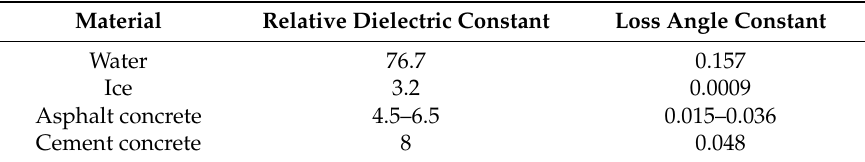
Table 1. Relative dielectric constant and loss angle constant of